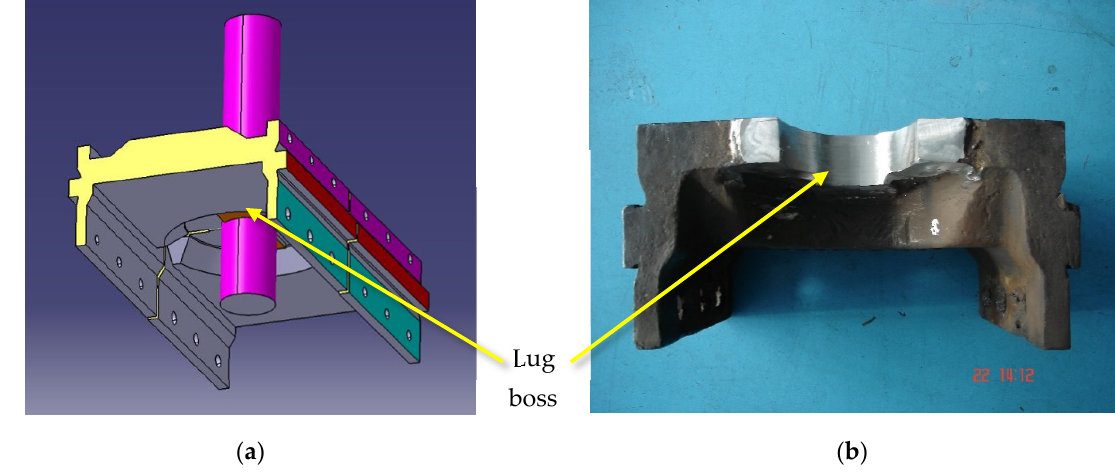
Figure 11. Trimming die with the active part geometry modified: ( a )—3D representation; ( b )—the image of the real trimming die.